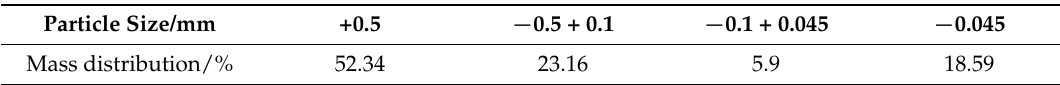
Table 1. The particle size distribution of rare earth ore.